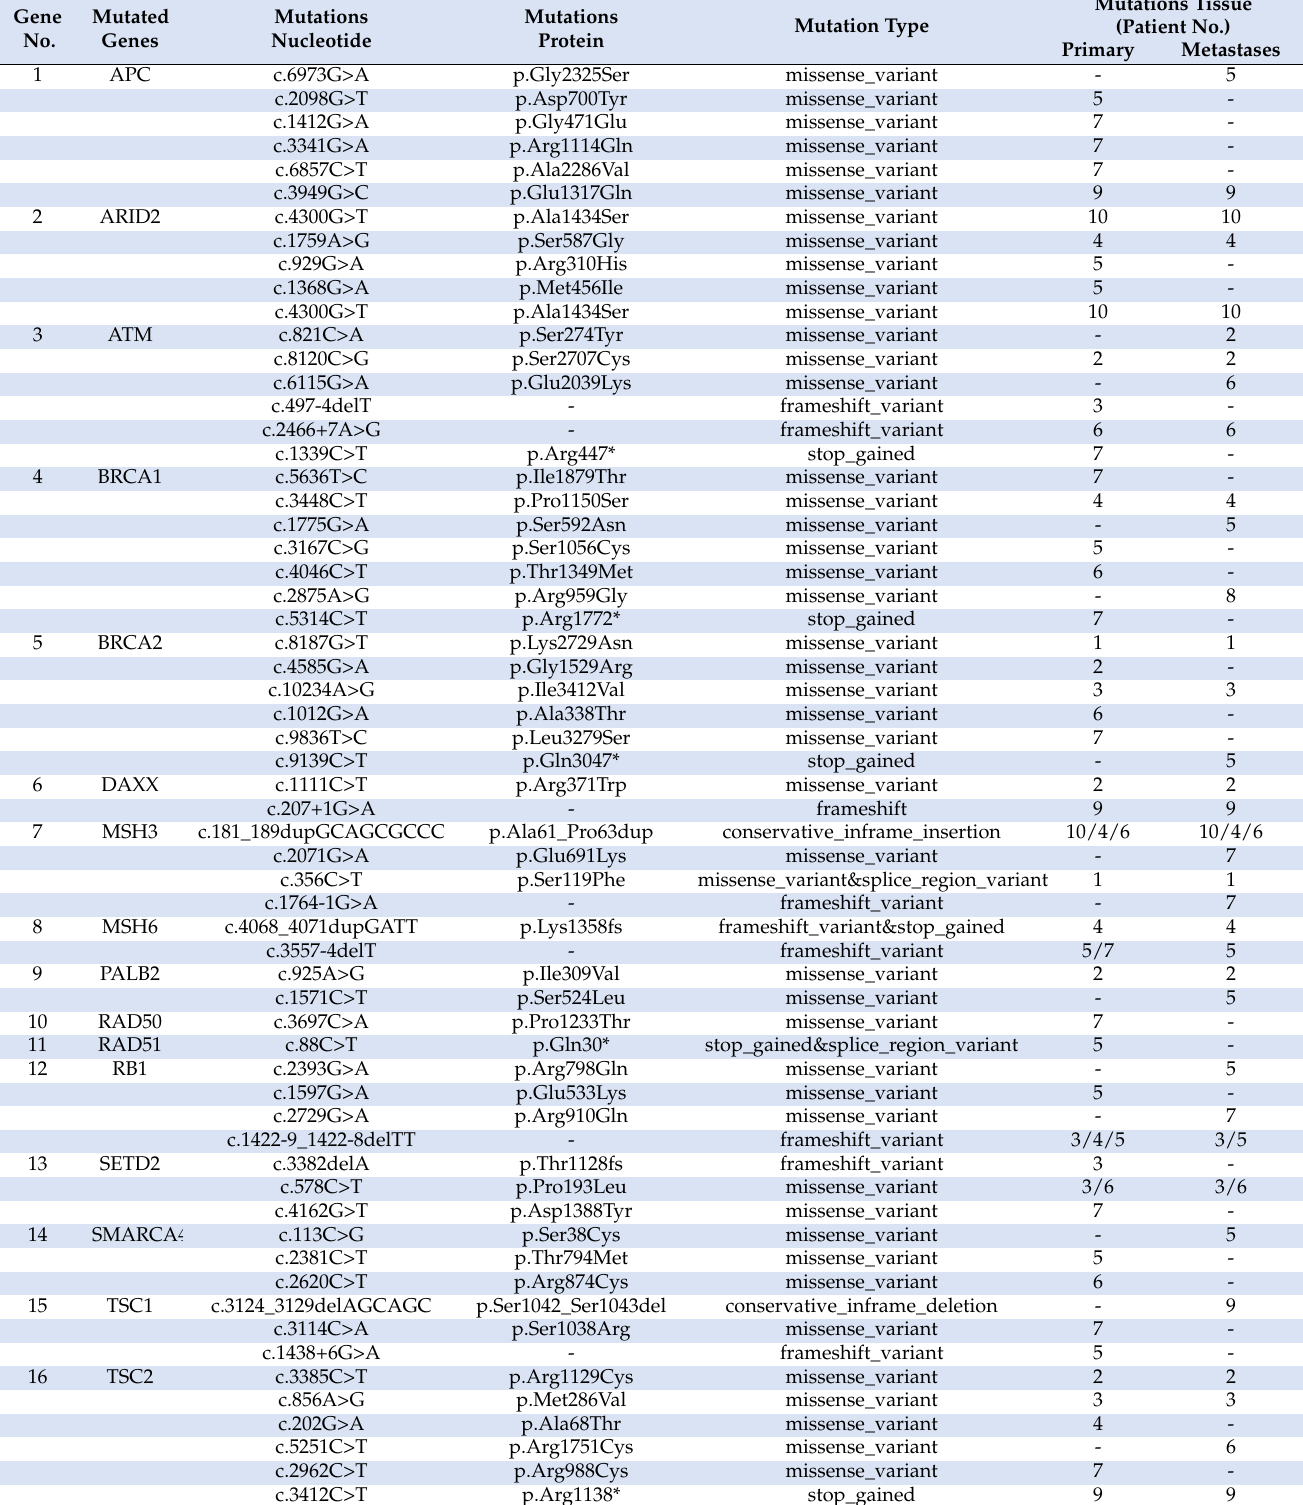
Table 2. Mutations in genes associated with PanNET are